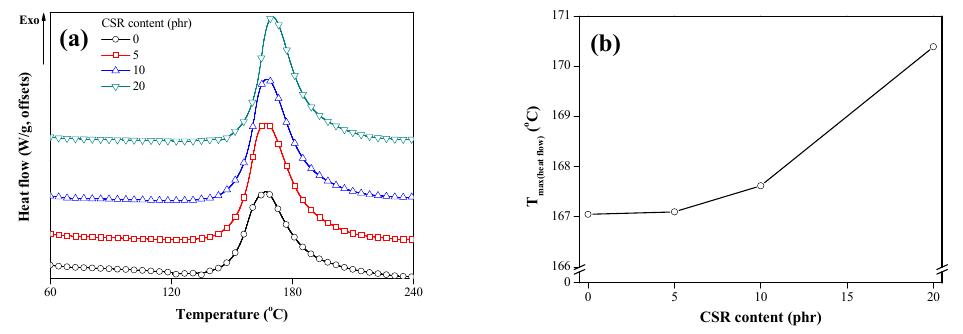
Figure 4. ( a ) Differential scanning calorimetry (DSC) curves of CSR/epoxy composites and ( b ) maximum temperature of heat flow.